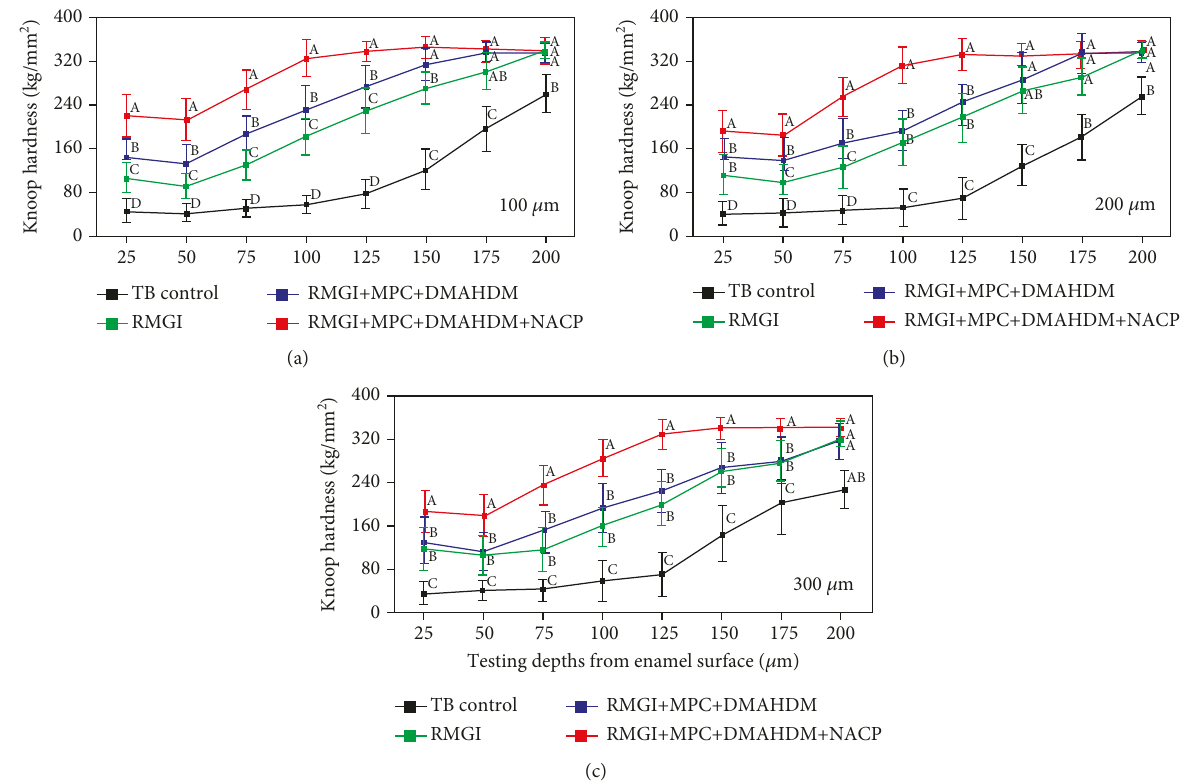
Figure 4: Enamel Knoop microhardness (KHN) values according to materials and testing depths of CSMH analysis ( mean ± sd ; n = 12 ), respectively, at (a) 100 μ m, (b) 200 μ m, and (c), 300 μ m distance from the margin of cements. Dissimilar letters indicate that values are signi fi cantly di ff erent with other groups ( p < 0 05 ) at each depth. (Adapted from reference [44], with